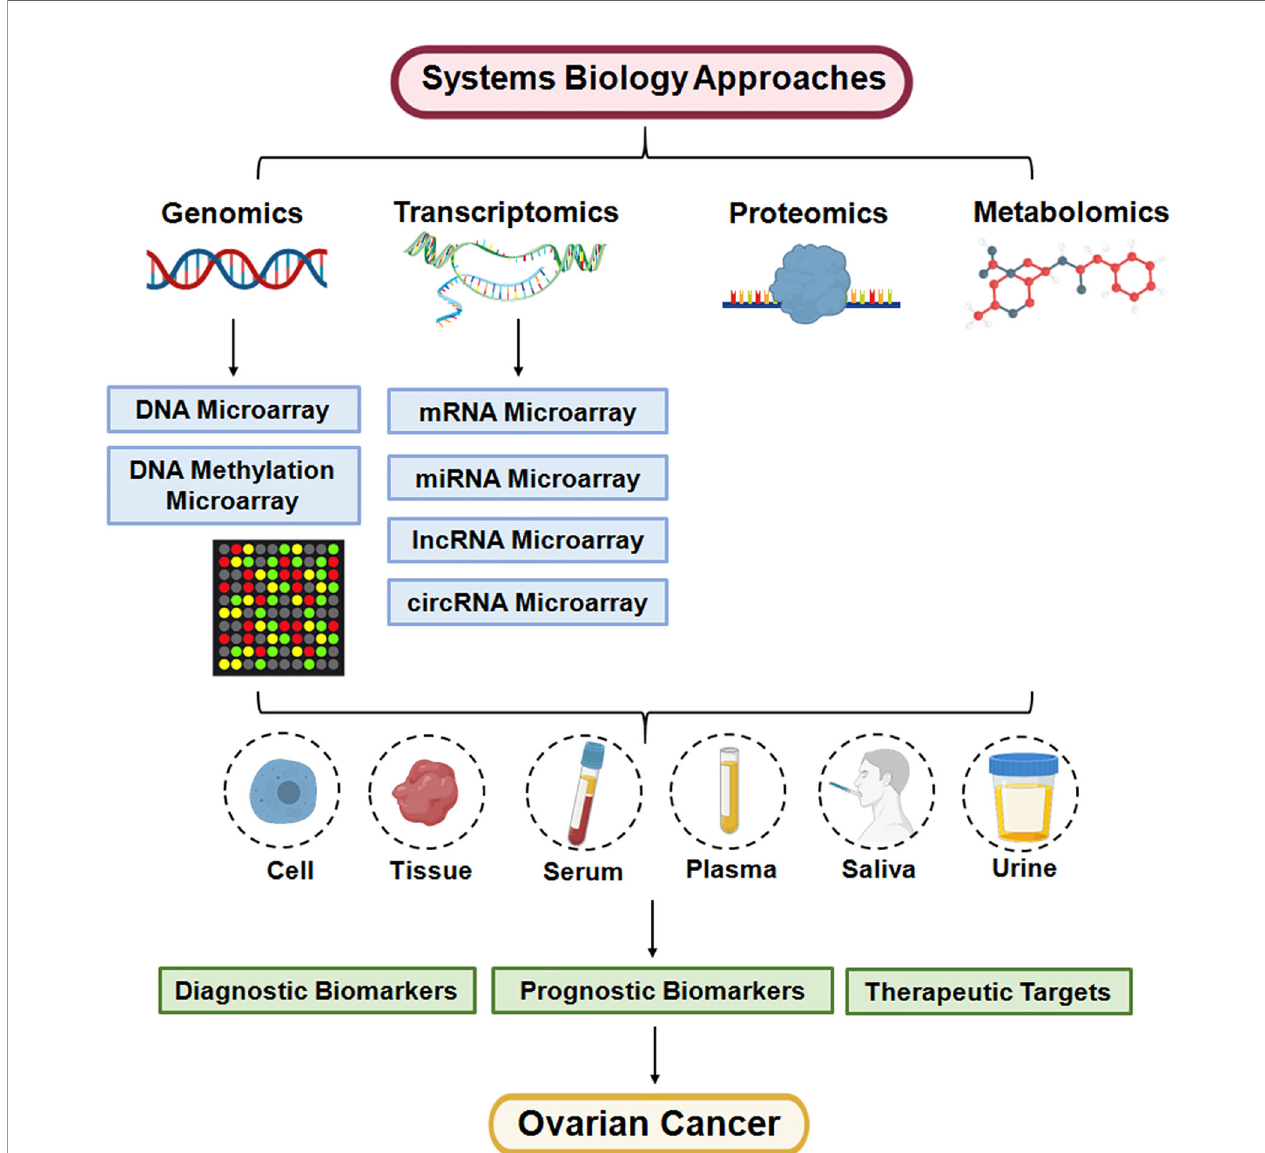
FIGURE 1 | Systems biology approaches are applied for personalized medicine of ovarian